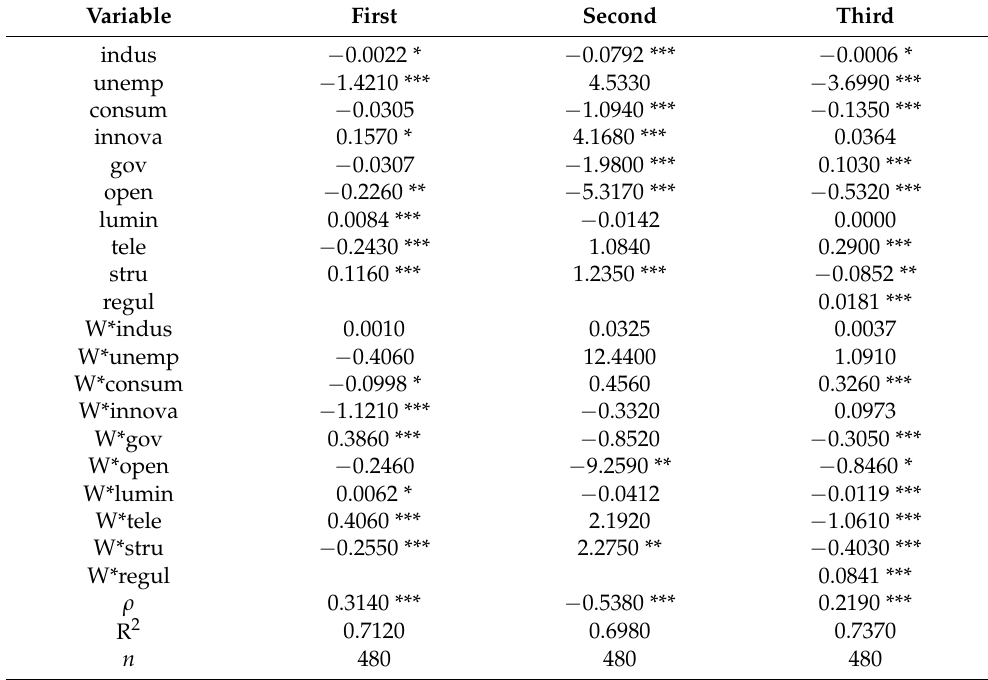
Table 6. Moderating effect test of environmental regulation.